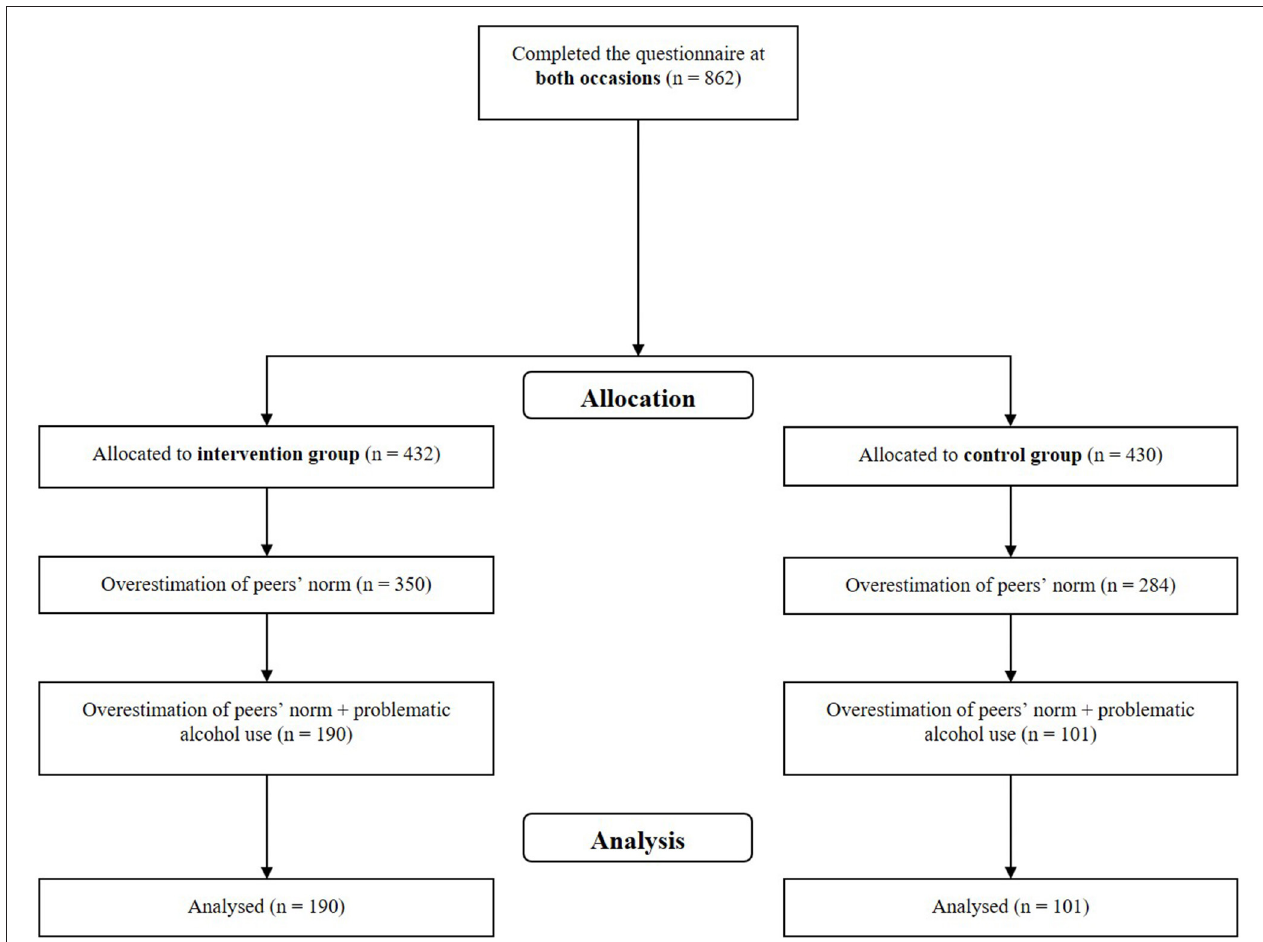
FIGURE 1 | Flowchart of our